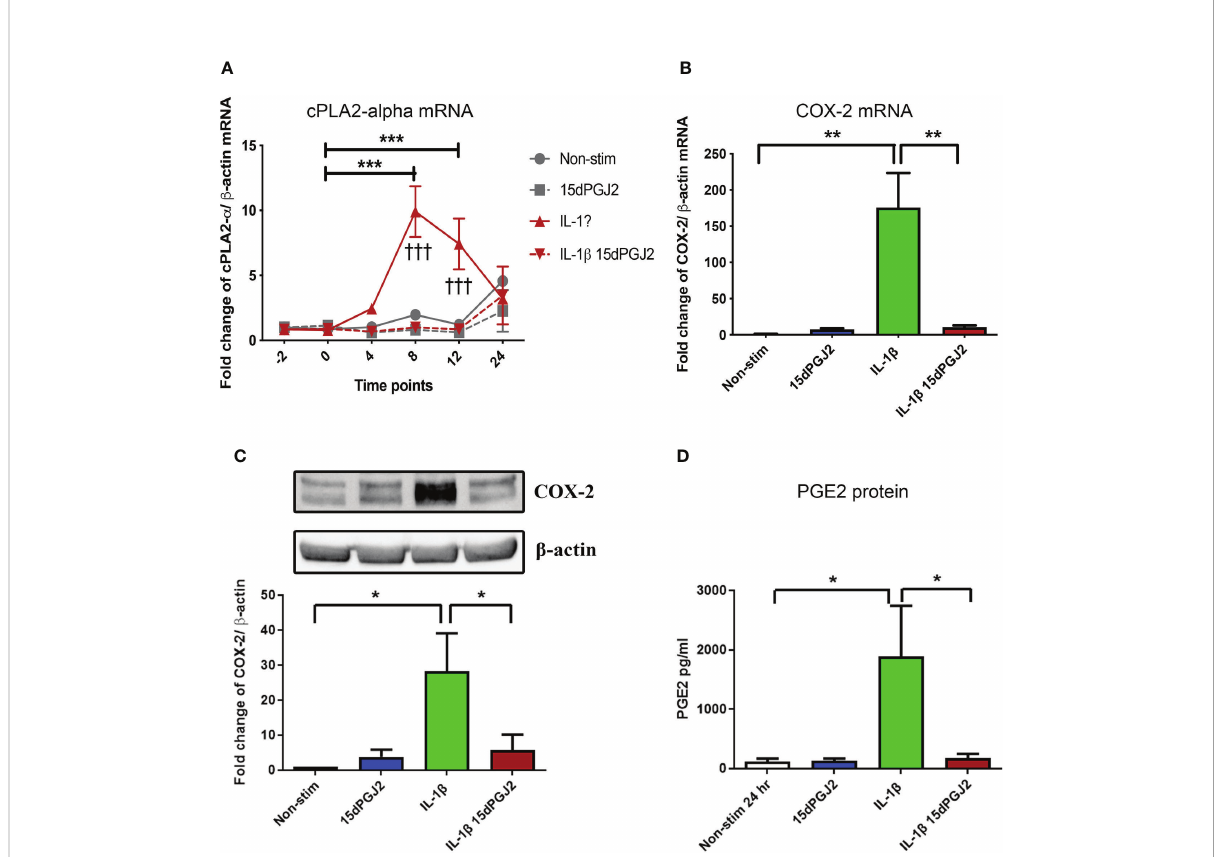
FIGURE 3 15dPGJ2 inhibits IL-1 b -induced contraction associated genes and proteins in myometrial cells. Myometrial cells were pre-incubated for 2 hours with 32µM 15dPGJ2 or vehicle before stimulation with 1ng/ml of IL-1 b . For cPLA2- a mRNA, cells were harvested at -2, 0, 4, 8, 12 and 24 post 1ng/ml of IL-1 b stimulation. COX-2 mRNA and protein were harvested after 4 hours. mRNA level was quanti fi ed using RT-qPCR and whole cells lysates were prepared and assessed by RT-qPCR and western immunoblotting used b -actin as the loading controland reference gene.